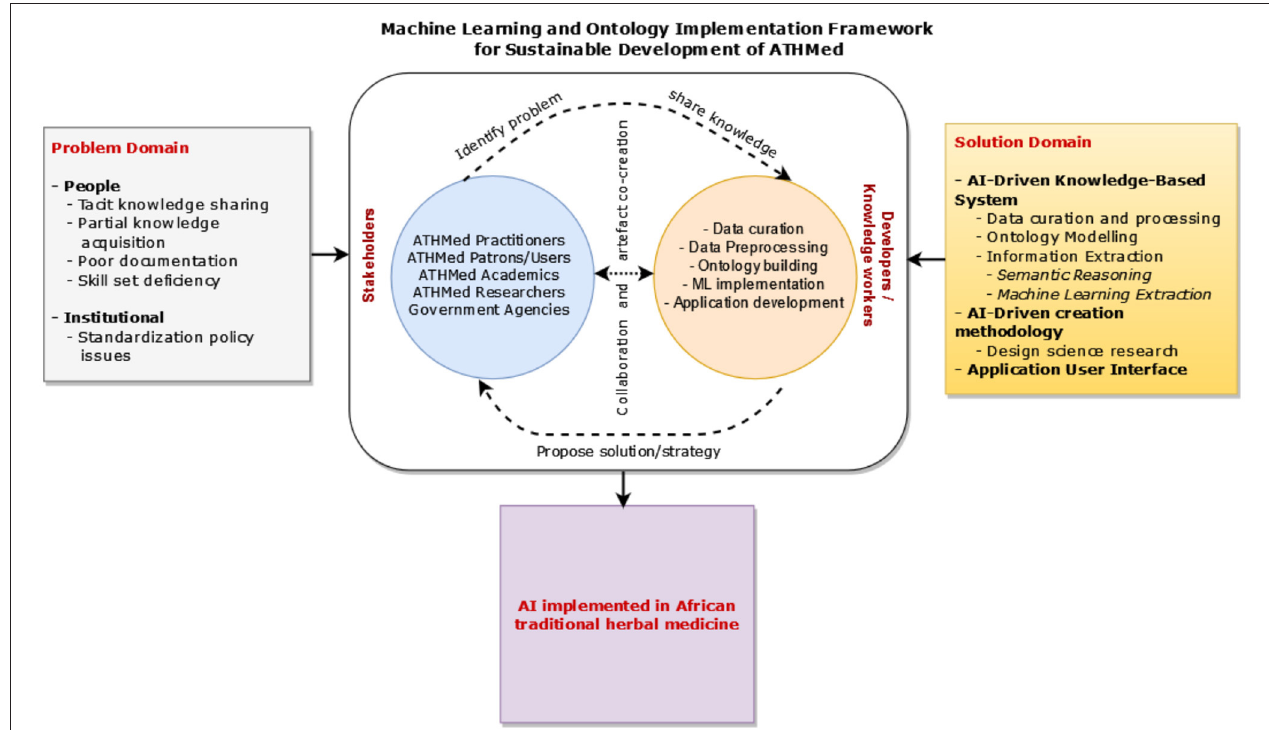
FIGURE 5 | Conceptual framework for machine learning and ontology driven sustainable development of